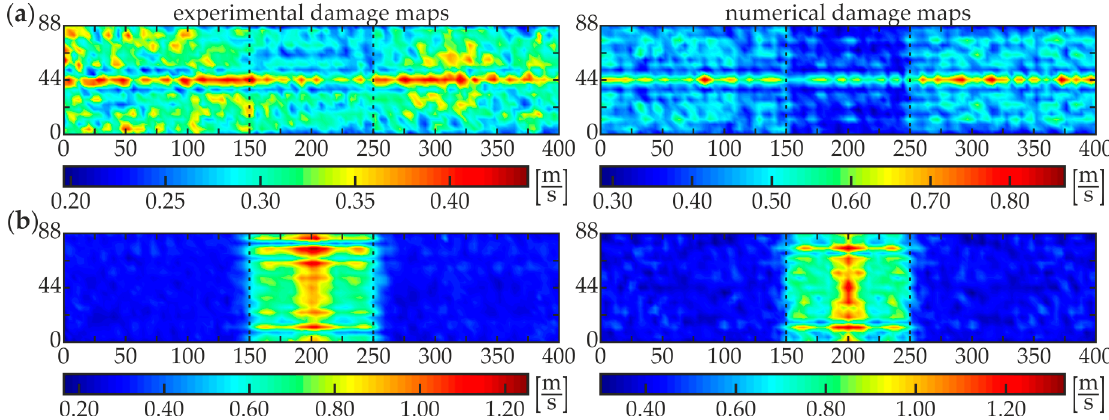
Figure 11. Experimental and numerical WRMS damage maps for specimen #3: ( a ) excitation P3 and ( b ) excitation P4.